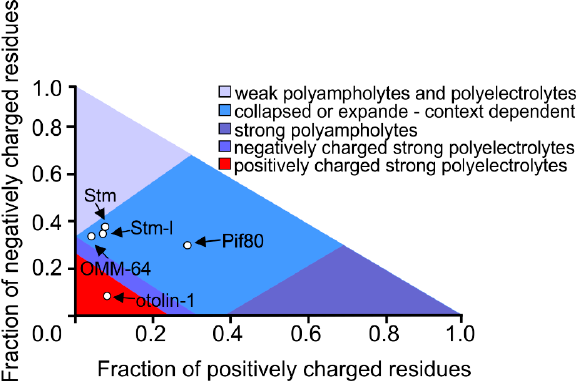
Figure 4. Phase diagram of proteins involved in the formation of fish otoliths. For the CIDER